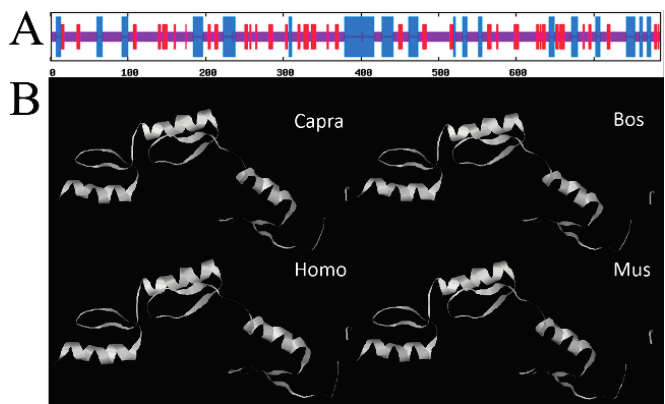
Figure 1. Structure prediction of SP1 proteins. ( A ) The secondary structure of SP1 protein. Blue color represents alpha helixes, red color represents beta bridges, and purple represents random coils; ( B ) The tertiary structure of SP1 protein in various species.